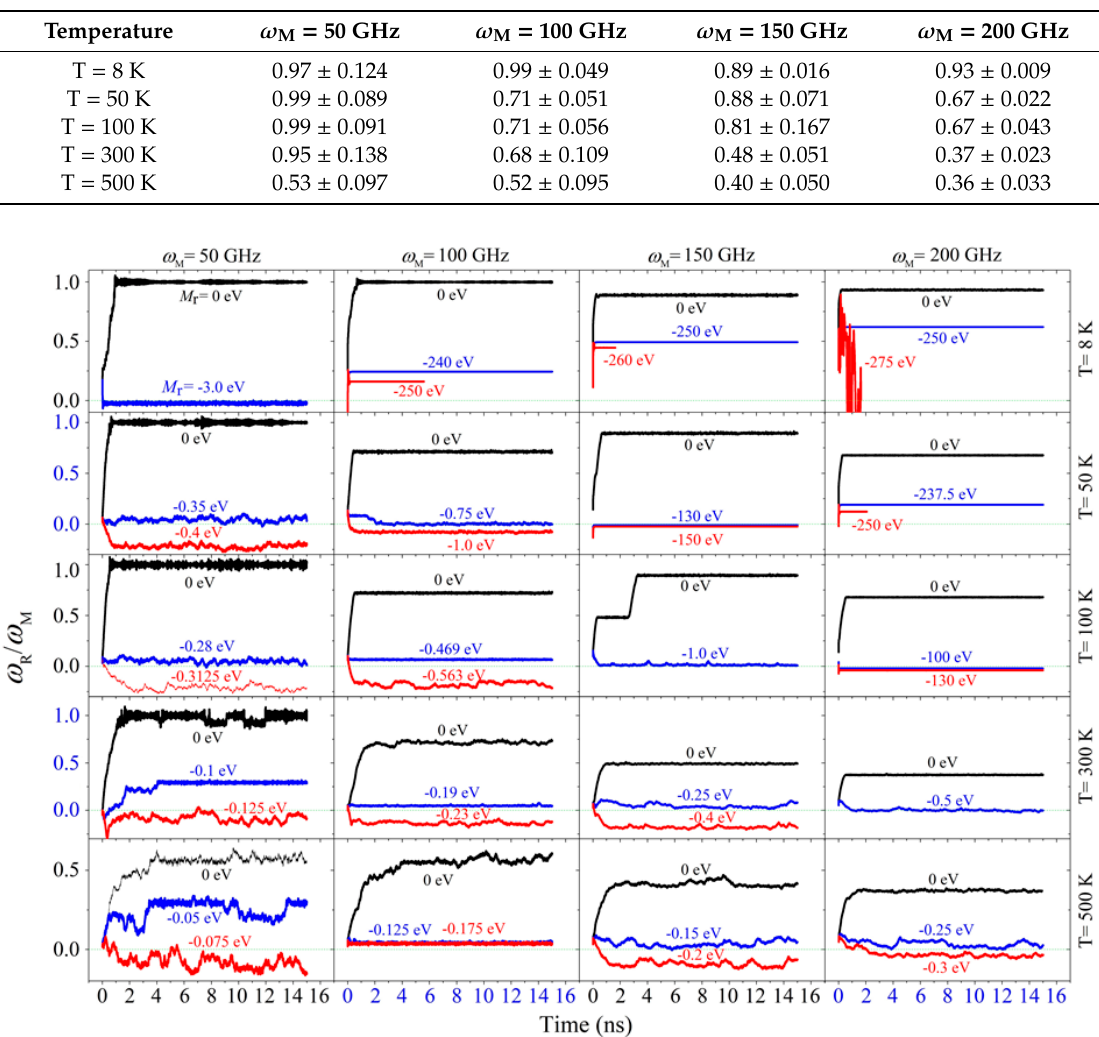
Figure 3. Historical curves of the rotation transmission ratio, i.e., R Tran , of the armchair model at different conditions. Not all the results involved in the bi-section algorithm were shown here. Only three of them in each case were listed for showing the critical values.